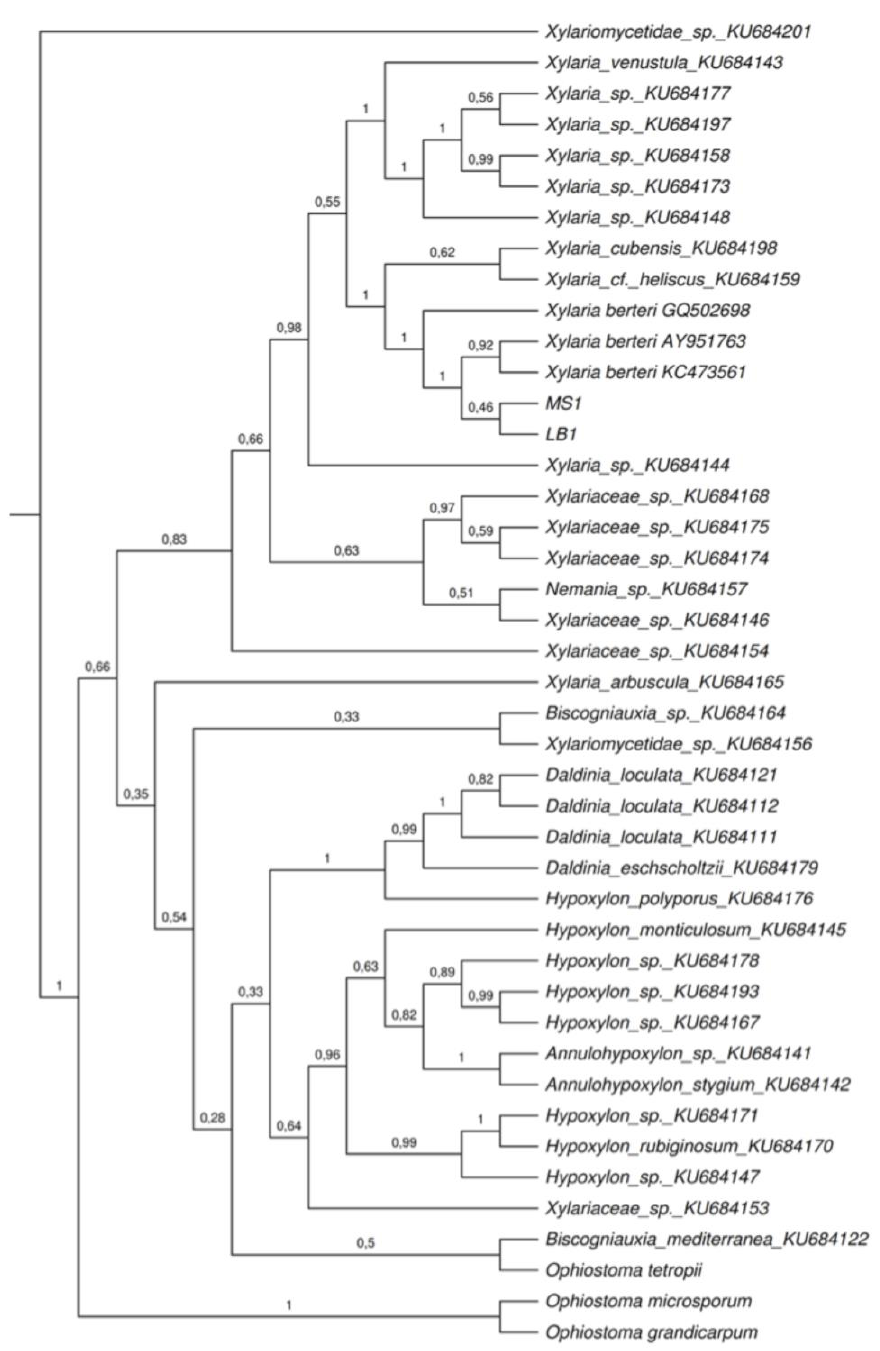
Figure 4. Phylogenetic relationships among endolichenic fungi isolated from Cladonia curta , sequences of endophytic fungi from other lichens [9] and closest match BLASTn. MS1 and LB1 corresponding to sequences of two fungi obtained in the present study. The phylogenetic tree created by using Bayesian statistical analysis with 10,000,000 million generation Markov Chain Monte Carlo based on one-locus dataset β -tubulin. The numbers at each internode indicates posterior probability values of a 95% majority rule consensus tree. Ophiostoma tetropii , Ophiostoma grandicarpum and Ophiostoma microsporum were used to root the trees.